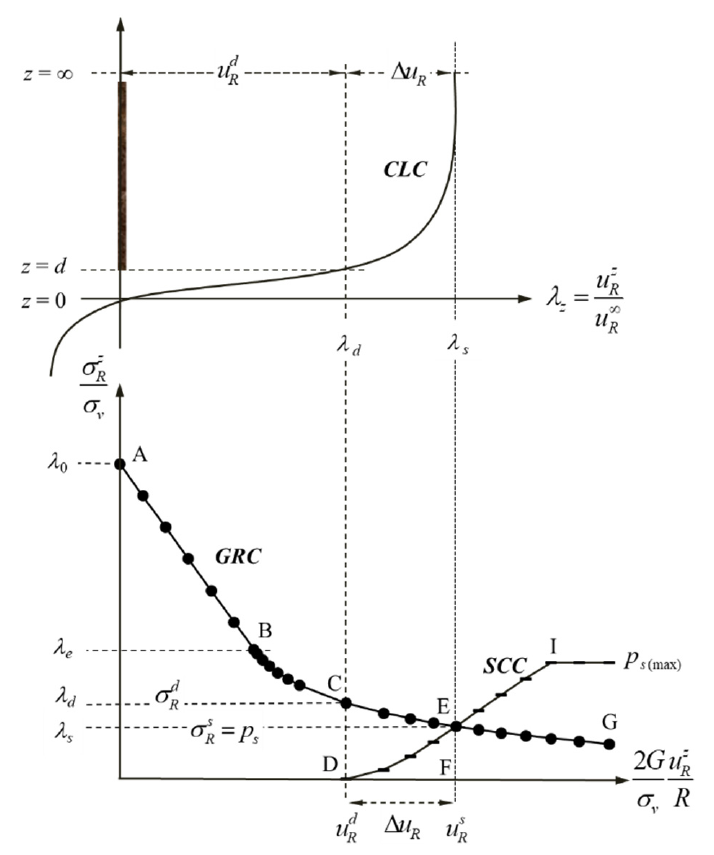
Figure 1. Graphical concept of the support-ground interaction in the analysis of CCM. placement of support-ground interaction in the analysis of CCM with the concept of